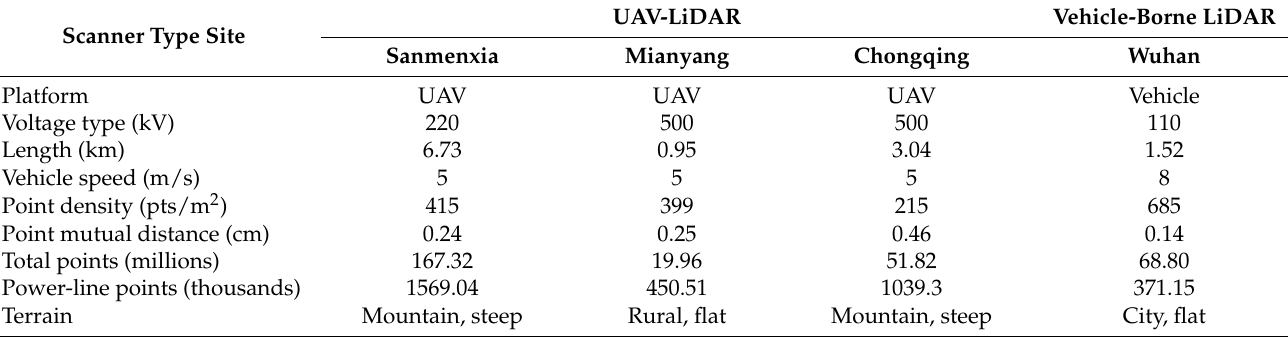
Figure 3. Test datasets. ( a ) Nanchong 220 kV (Dataset 1), ( b ) Mianyang 500 kV (Dataset 2), ( c ) Sanmenxia 220 kV (Dataset 3) and ( d ) Wuhan 110 kV (Dataset 4). The zoomed pictures show part of the four datasets. Table 1. Description of the experiment